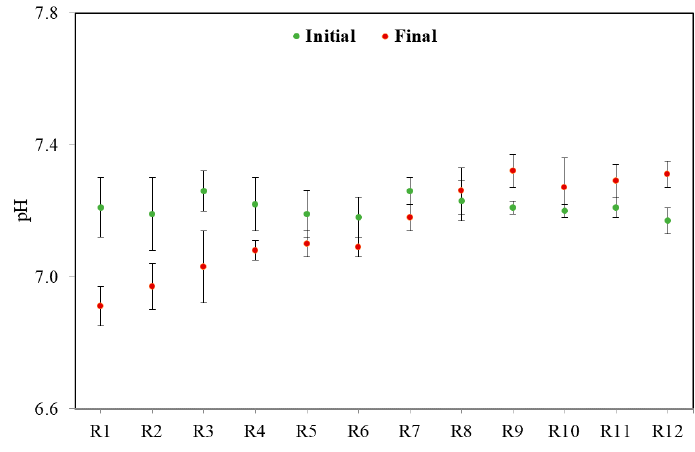
Figure 2. pH for all the reactors.